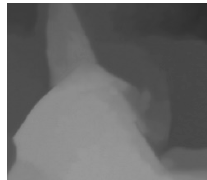
Figure 8. Performance comparison with p